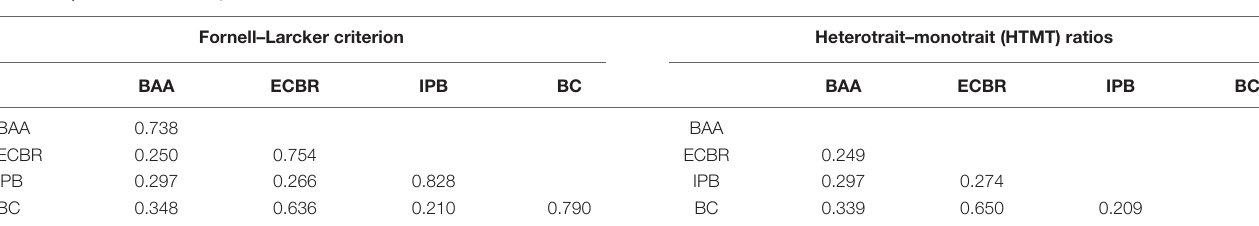
TABLE 3 | Discriminant